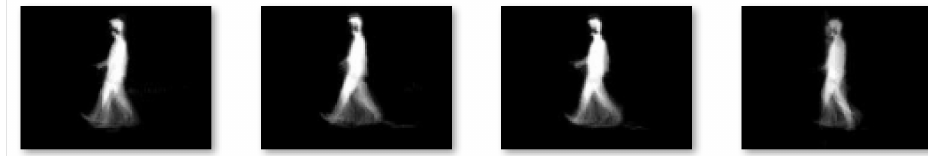
Figure 7. Result samples of GE images for one person from video sequences.